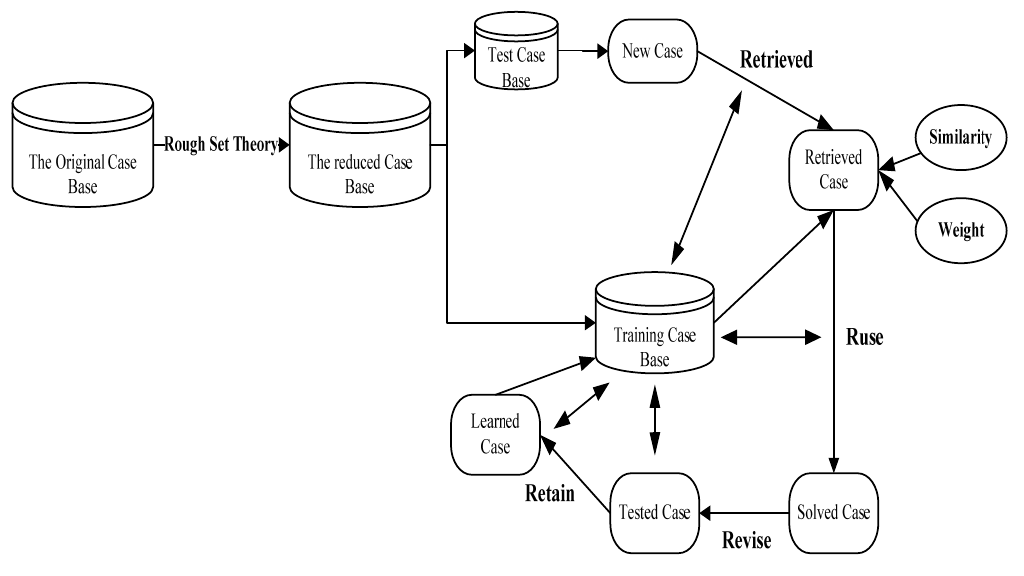
Fig. 1. Framework of combined approach of RST and CBR